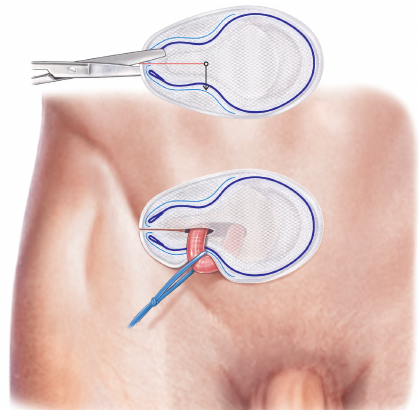
Figure 8: The Onflex mesh is cut and the tails are placed around the spermatic cord.